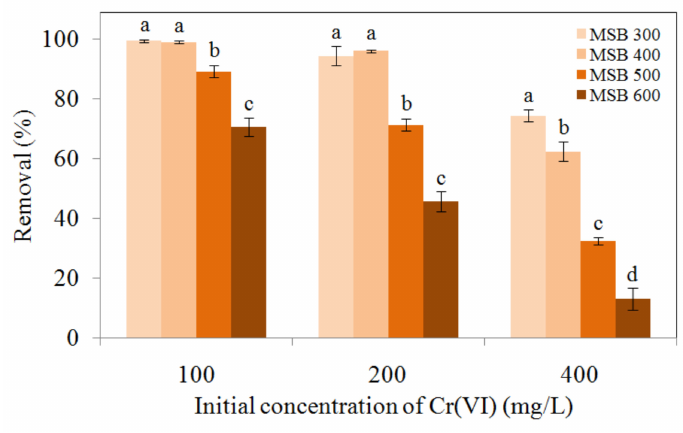
Figure 4. Comparisons of Cr(VI) 100, 200, and 400 mg / L removal by MSB from di ff erent pyrolytic temperatures at pH 2.0. The error bars marked with di ff erent letters (a, b, c, and d) indicate significant di ff erences ( p <